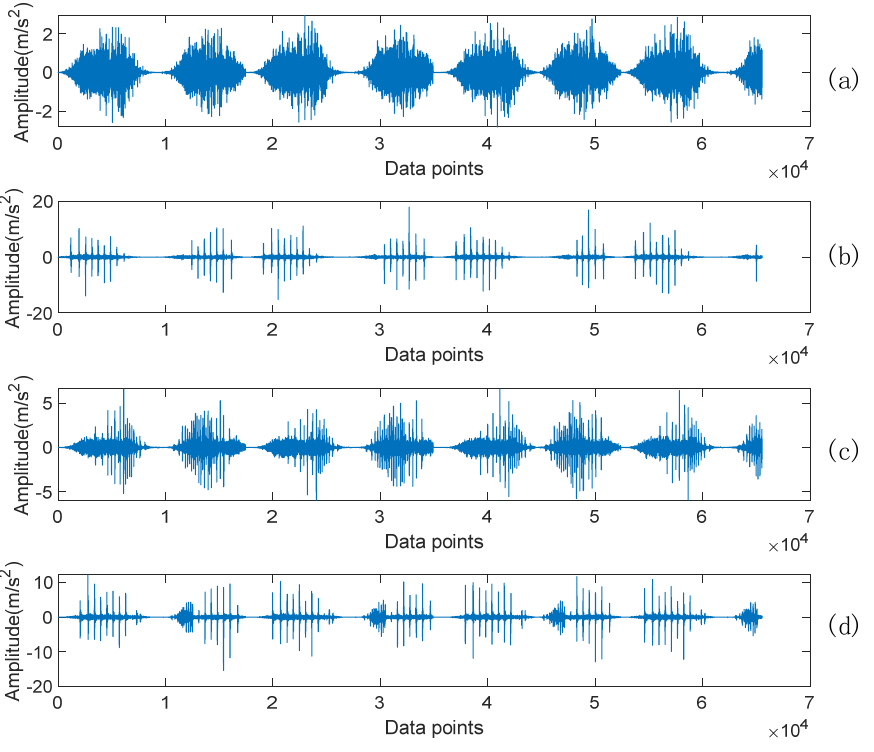
Figure 10. Vibration signal of the RV reducer in four healthy conditions: ( a ) normal condition, ( b ) multitooth wear of planetary gear, ( c ) multitooth wear of the sun gear, and ( d ) compound fault. The RV reducer drives the swing arm to make a reciprocating motion. A reciprocat- ing motion takes 2.7 S. At the sampling frequency of 6400 Hz, the RV reducer contains 17,280 data points in one operation cycle. To ensure the speed and recognition efficiency of the network, the number of data points for a set of training data should be 2 n and contain at least one run cycle, so the data length for each set of training data should be set to 32,768. After the training data length is determined, the data enhancement of the 1D vibration signal of the RV reducer is performed using the overlap slicing method. Data enhancement can increase the training data and improve the model’s generalization ability. In data enhancement, the equal data length window is used to divide the data of one-dimensional vibration signal, and more data samples are obtained by moving the window. The window moves one step s forward to get a data sample x i until sufficient data samples are obtained.